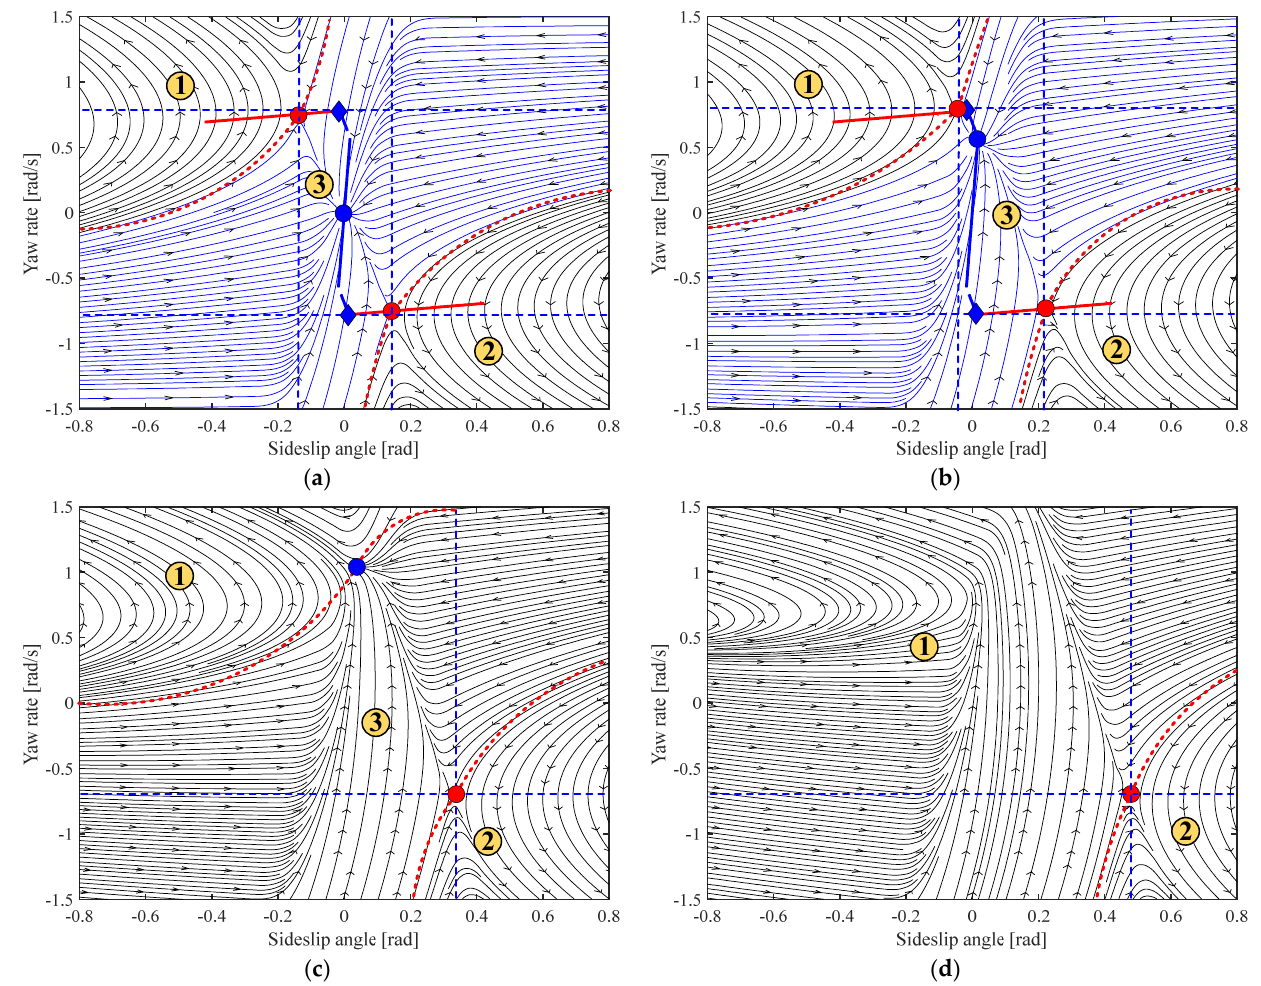
Figure 4. ( a – d ) shows the phase portrait with the front wheel steering angle of 0 rad, 0.1 rad, 0.25 rad, 0.35 rad, respectively. The red dotted line represents the boundary of different regions; the blue dotted line represents the position of saddle points.